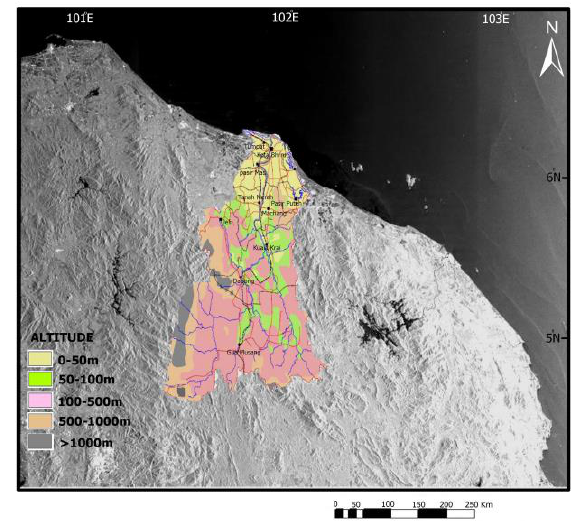
Figure 3. ScanSAR HV polarization image of the Kelantan state superimposed by general topography map.